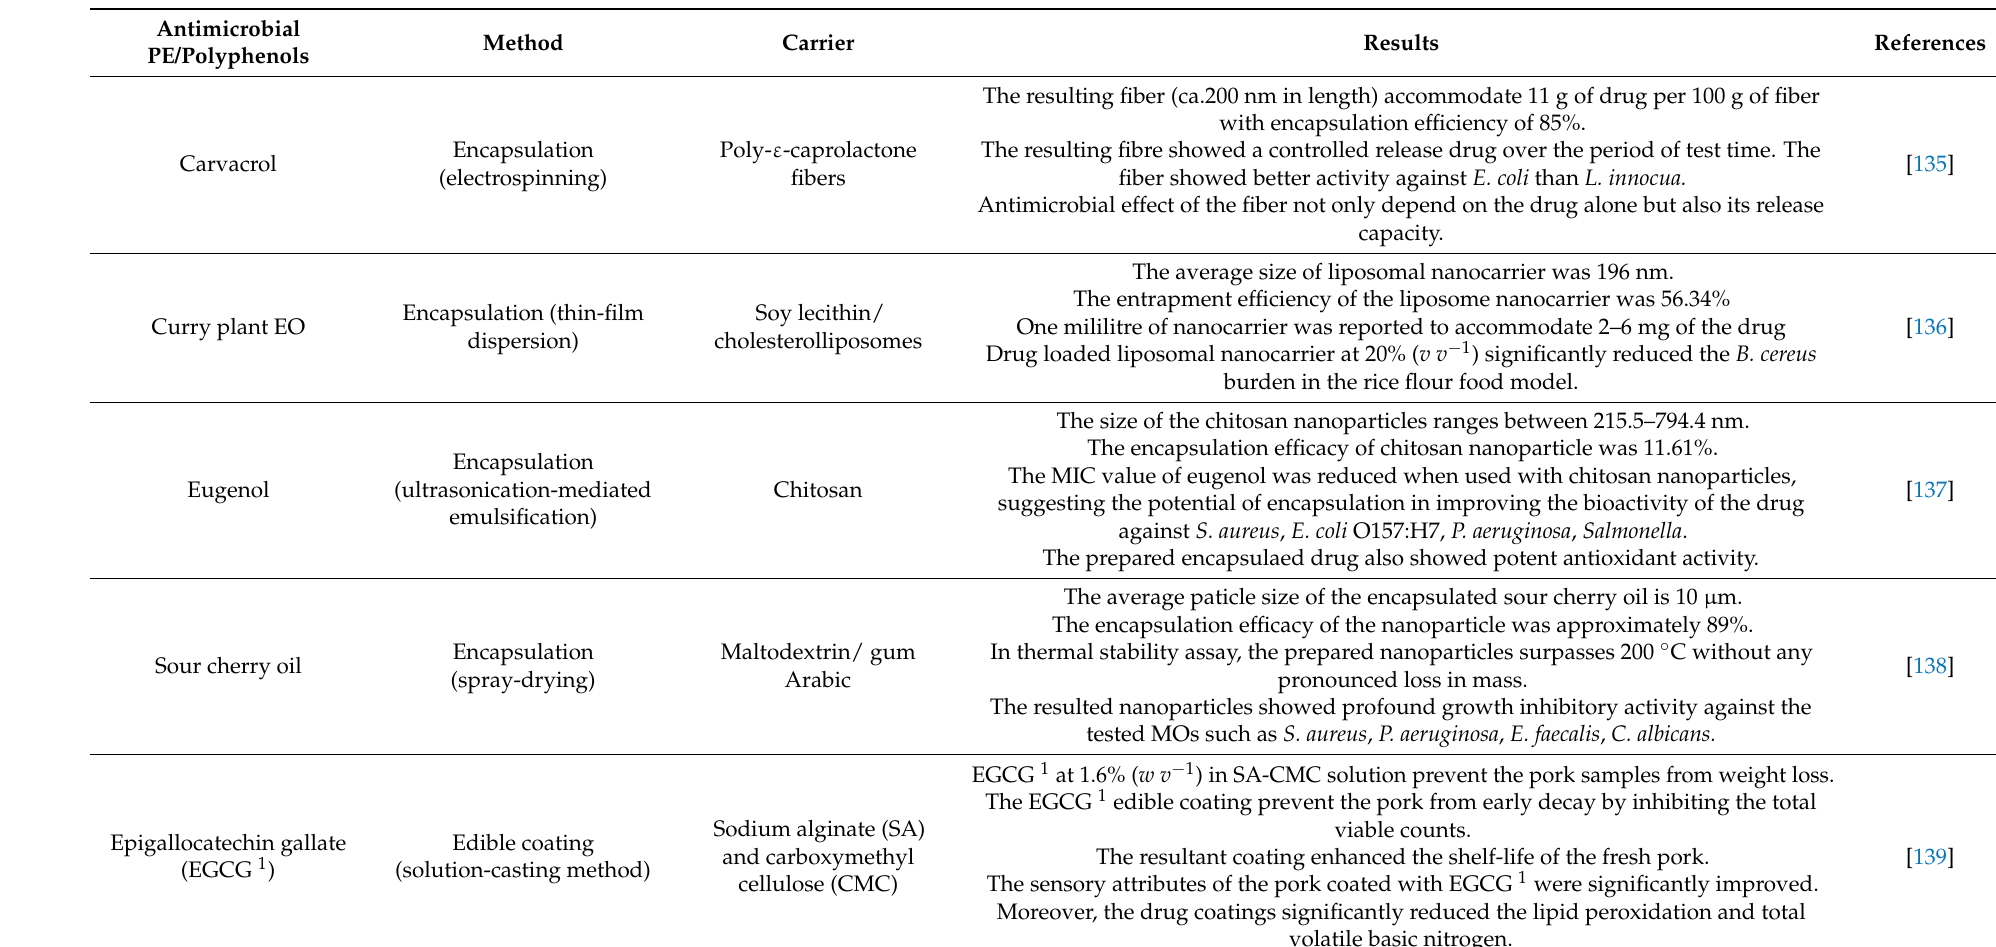
Table 2. Recent studies showing the application of polyphenols rich PE or alone antimicrobial polyphenols in food